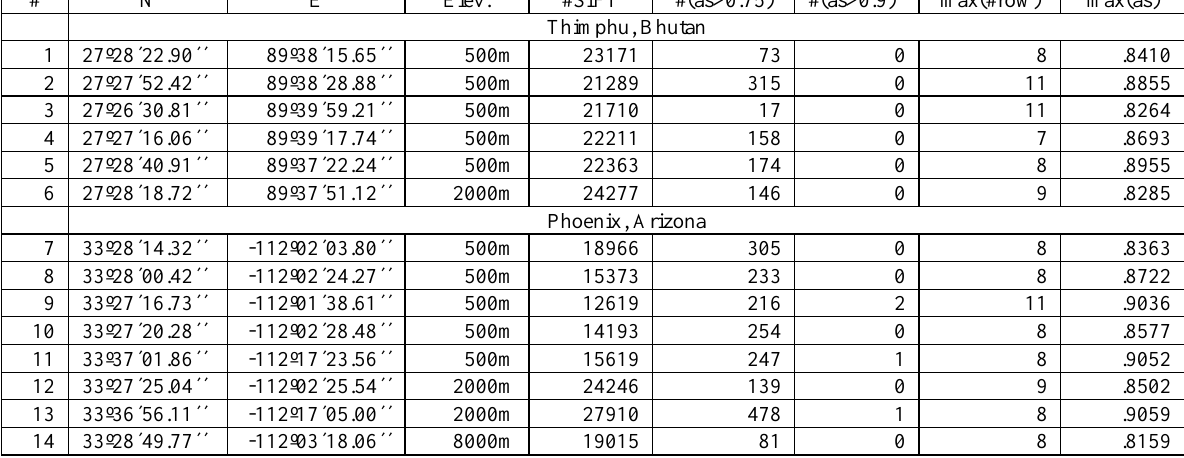
Table 1. Example pictures, Geo-reference, and resulting numbers and properties of ∑